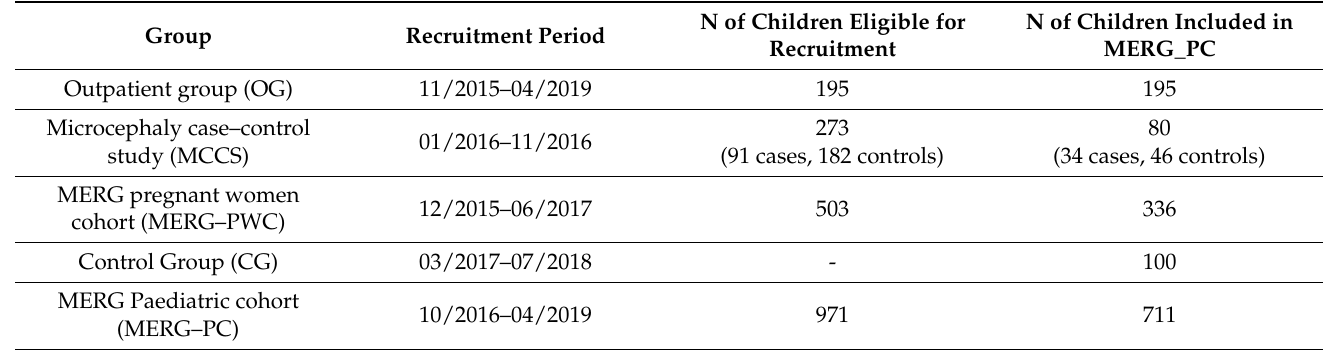
Table 1. Recruitment of the children’s